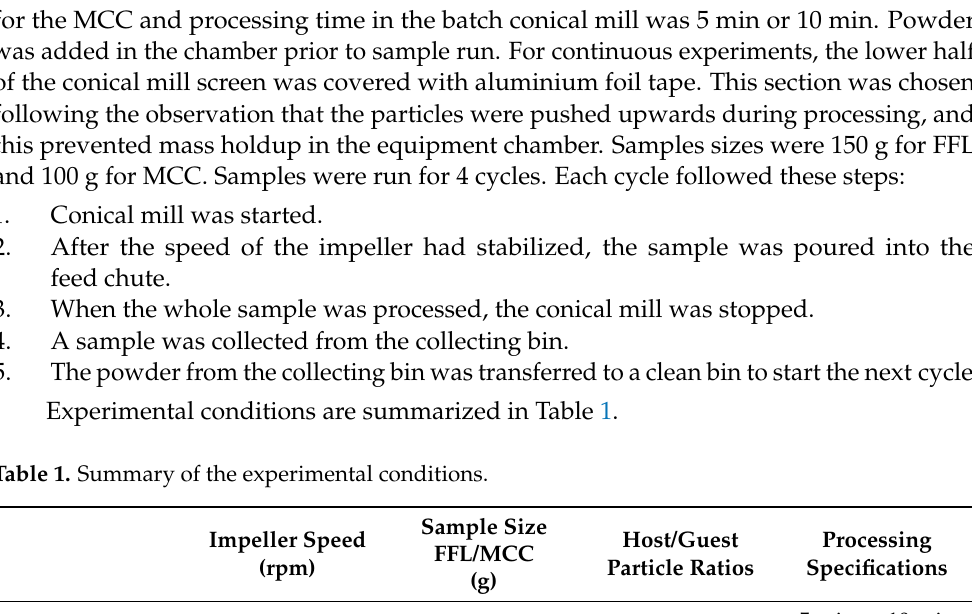
Impeller Speed (rpm)